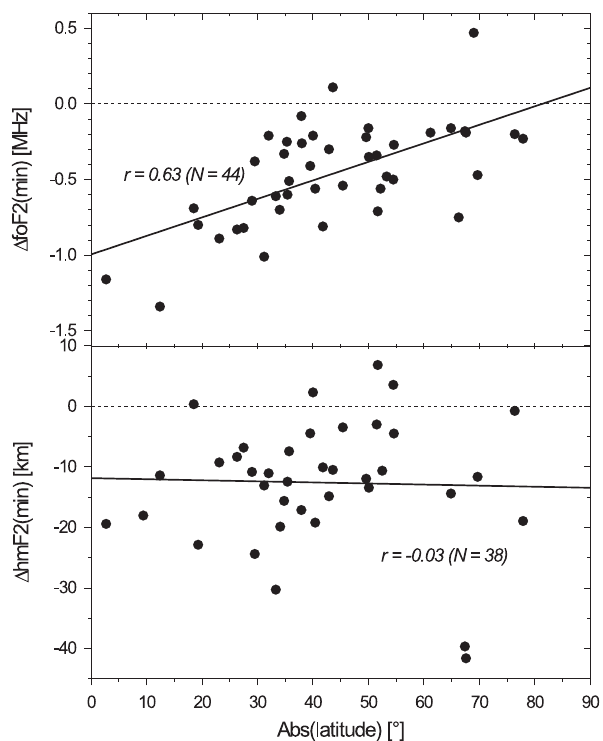
Fig. 13. Minimum values of 1 fo F2 and 1 hm F2 from the years 2007–2009 in dependence on the absolute values of the lat- itude of the investigated stations ( N : number of stations, r : correla- tion